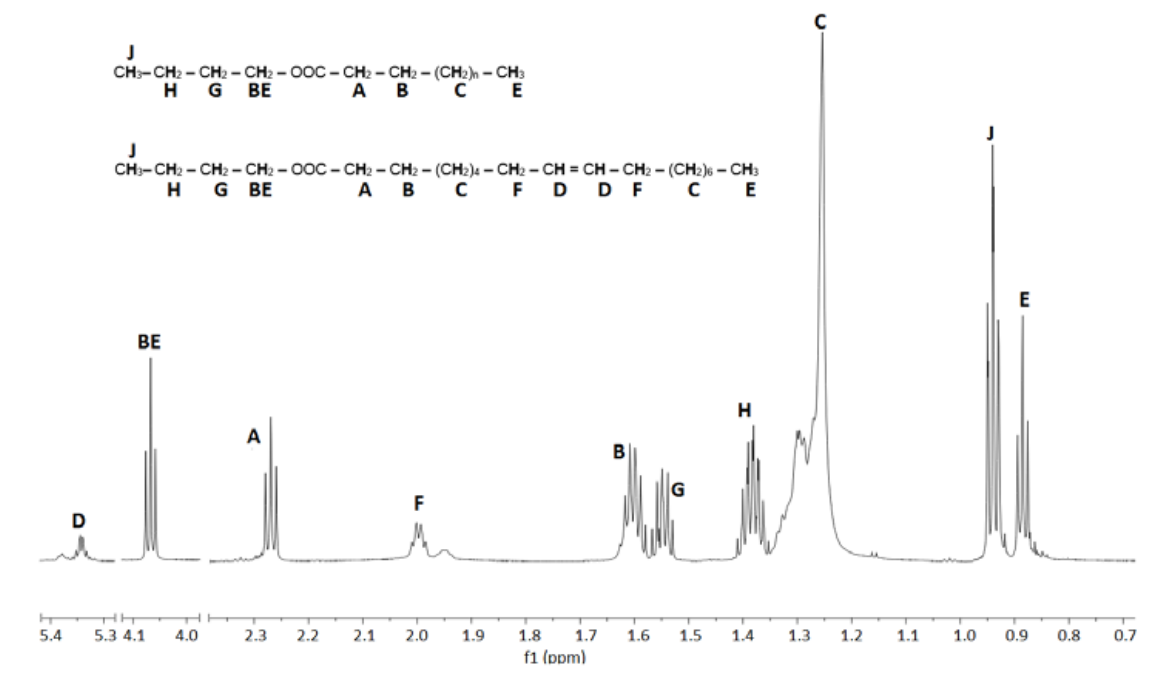
Figure 3. 1 H-NMR spectra for FABE obtained from beef tallow by supercritical 1-butanol.